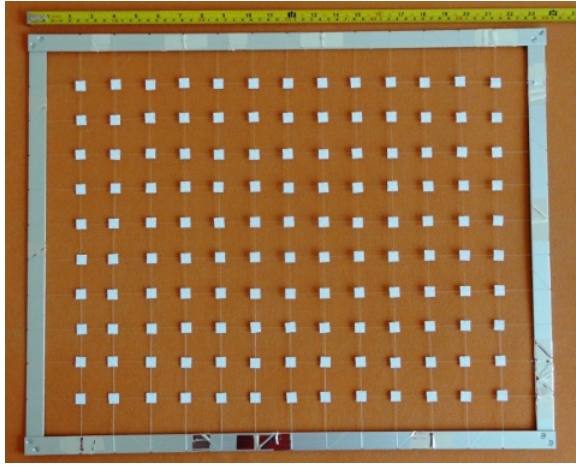
Fig. 6. The measuring